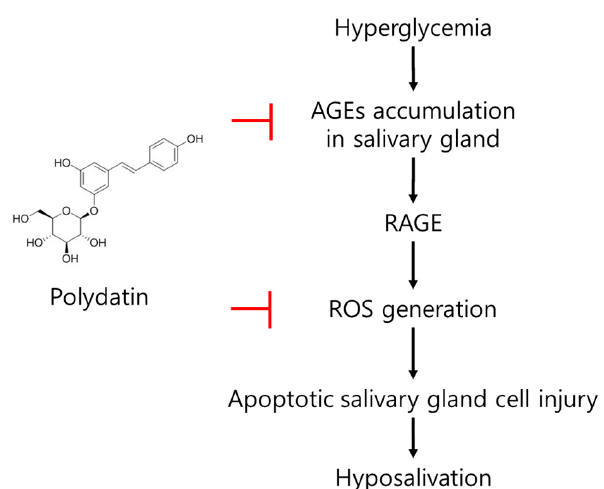
Figure 7. The possible mode of action of polydatin on diabetes-induced hypofunction of salivary glands.